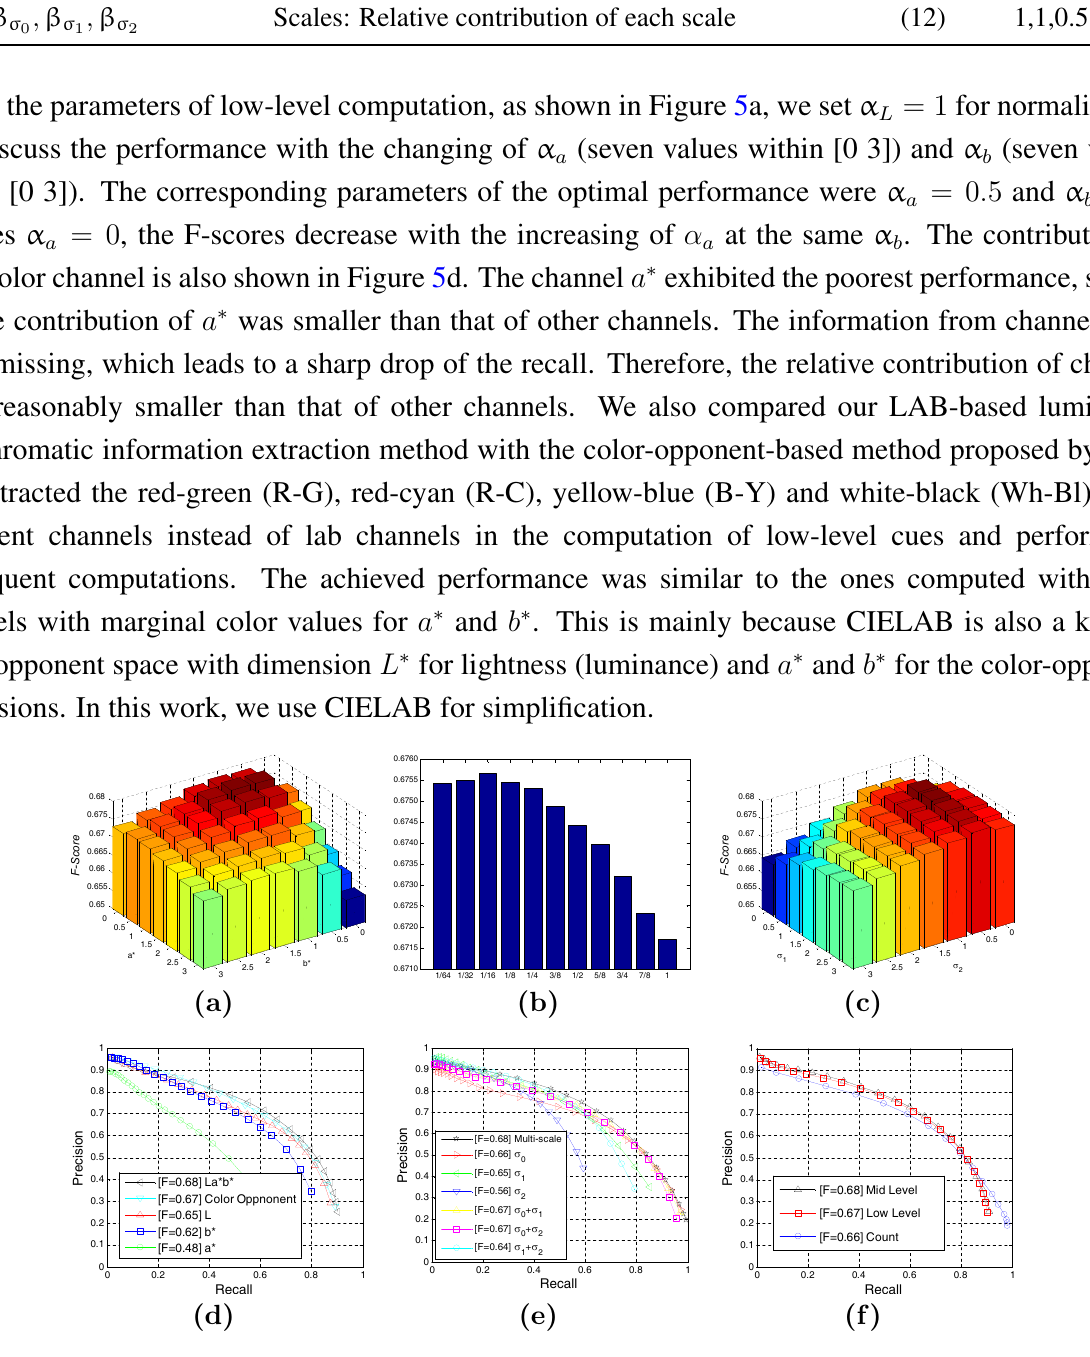
Figure 5. Performance tests with the parameters in our model. ( a ) Performance with the changing of low-level cue parameters; ( b ) performance with the changing of mid-level cue parameters; ( c ) performance with the changing of the relative contribution of each scale; ( d ) P-R curves of L ∗ a ∗ b ∗ -based and color opponent-based methods; ( e ) P-R curves of each scale; ( f ) P-R curves of the performance of each part in our